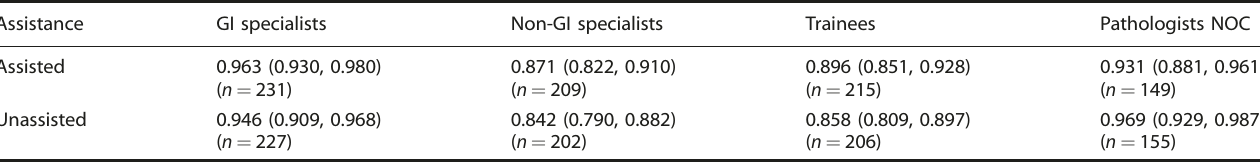
Table 2. Pathologist unassisted and assisted accuracies, by experience level a .